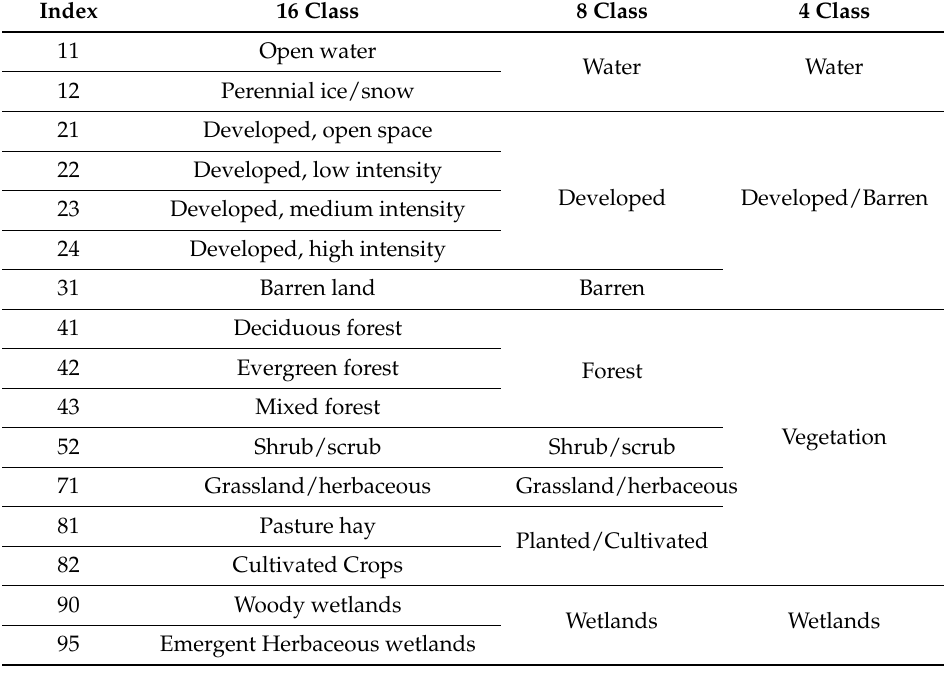
Table 1. The land cover class grouping strategy.